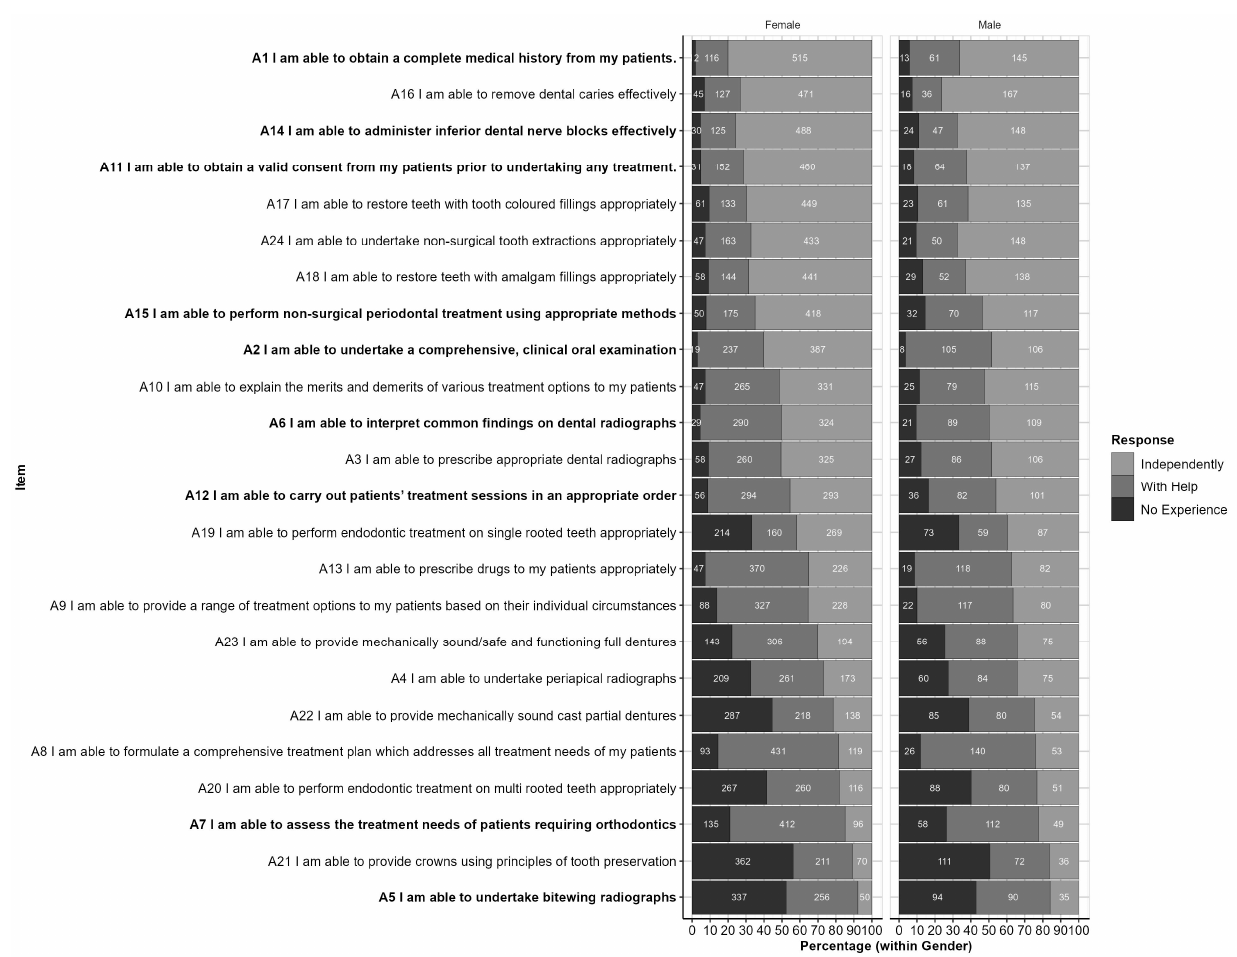
Figure 2. Responses by Part A items (within Gender): Reponses are ordered from highest to lowest proportion of ‘Independent’ responses (across Genders). Items for which response profiles differ significantly by gender ( p < 0.05) are highlighted in bold text. Table 2. Association between Gender and Item Responses for Part A: Specific p -values from Chi- Squared tests of association for items showing a statistically significant association between Gen- der and Item Responses for Part A.